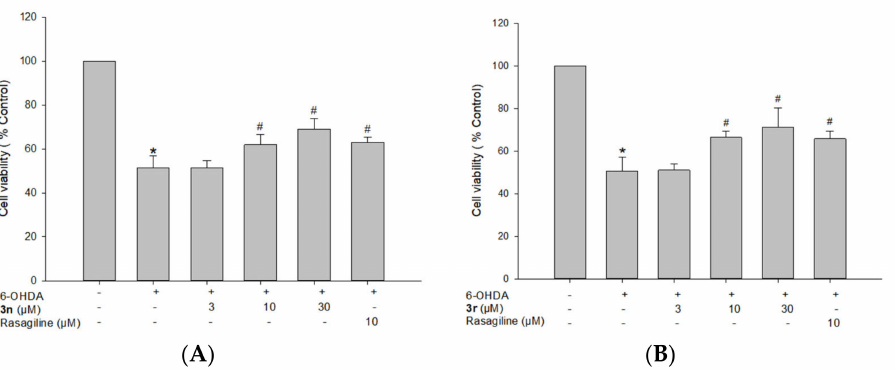
Figure 12. Neuroprotective effects of compounds 3n ( A ) and 3r ( B ) on 6-OHDA-induced oxidative toxicity in PC12 cells. PC12 cells were pre-treated with the test compounds or rasagiline at the indicated concentrations for 4 h and exposed to 6-OHDA (50 µ M) for an additional 24 h. Cell viability was evaluated by MTT assay as described in the Materials and Methods section. Data are expressed as the mean ± SEM of at least three independent experiments. * p < 0.05 and # p < 0.05 vs.